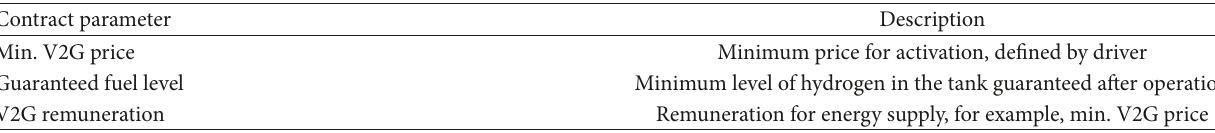
Table 1: Price-based contract parameters.